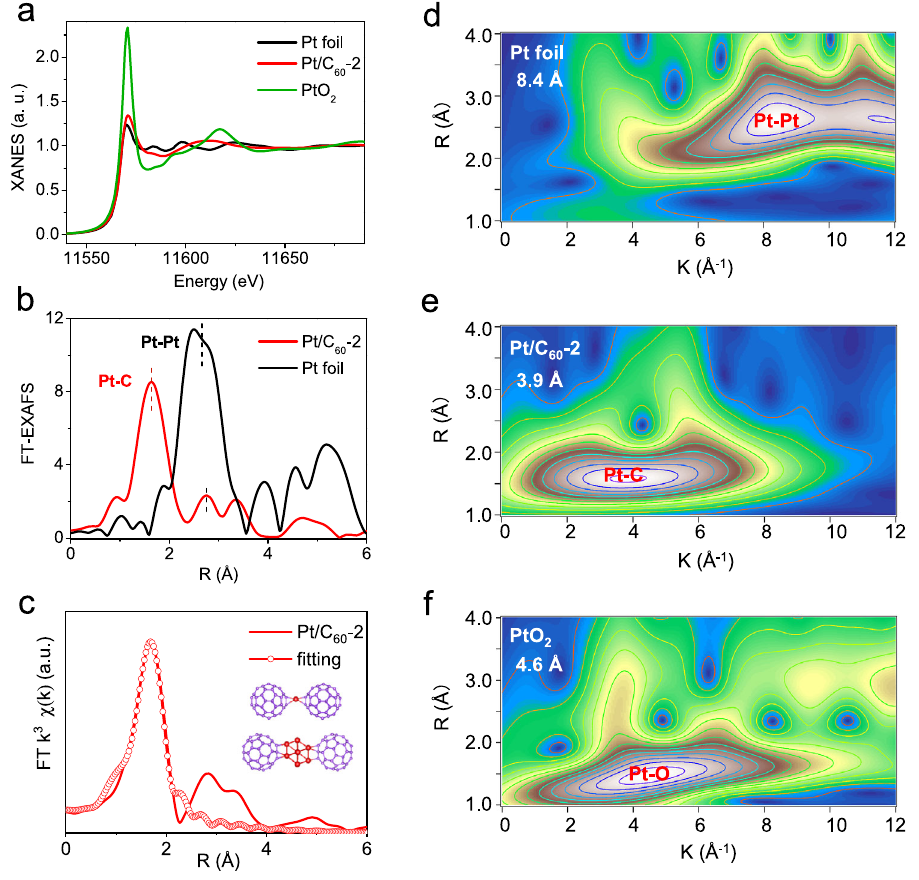
Fig.4|X-rayabsorptionspectroscopicstudies.a XANESspectraofthePtL 3 -edge of Pt/C 60 -2,PtfoilandPtO 2 b FT-EXAFSspectraofthePtL 3 -edge ofPt/C 60 -2andPt foil. c Corresponding EXAFS fi tting curve for the Pt/C 60 -2. The inset shows the